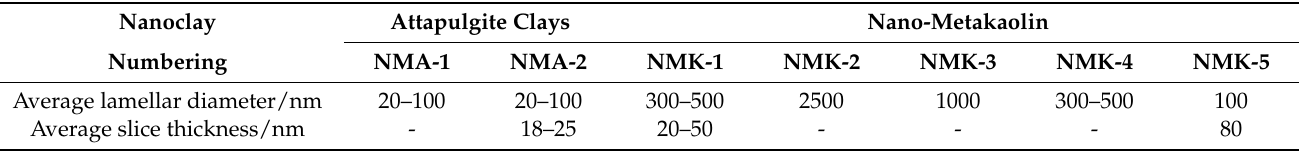
Table 2. Physical performance